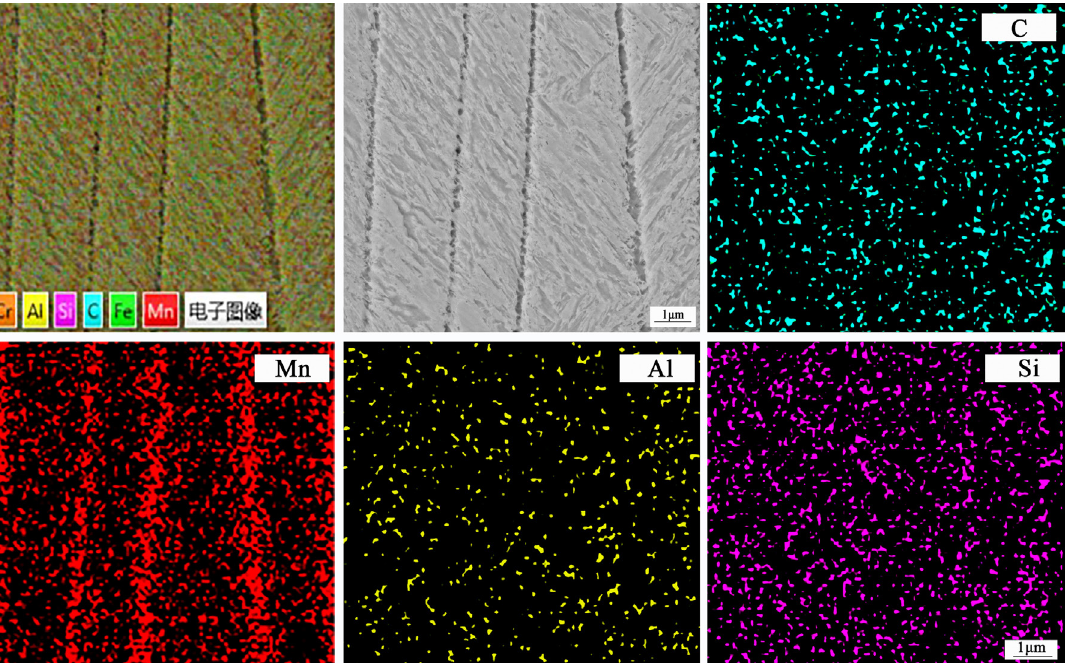
Figure 4. Scanning electron microscope images of microstructure and element distribution in the fusion zone.